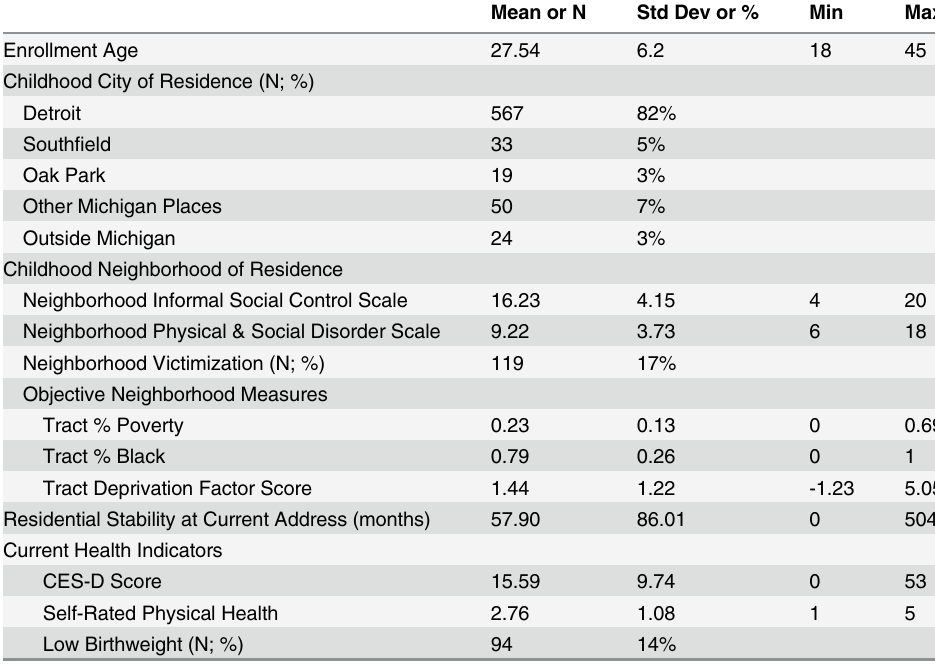
Table 1. LIFE Study Neighborhood at Age 10 and Current Health Univariates. Mean or N Std Dev or % Min